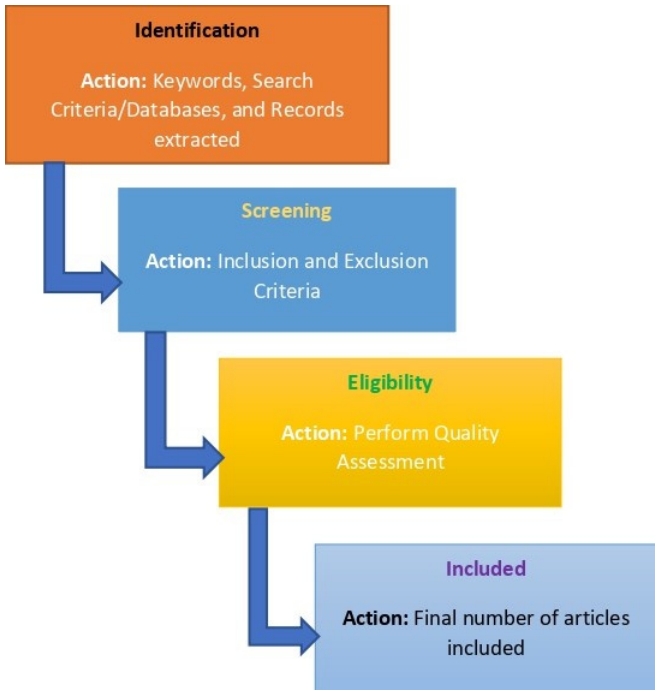
Figure 1. PRISMA framework method steps.